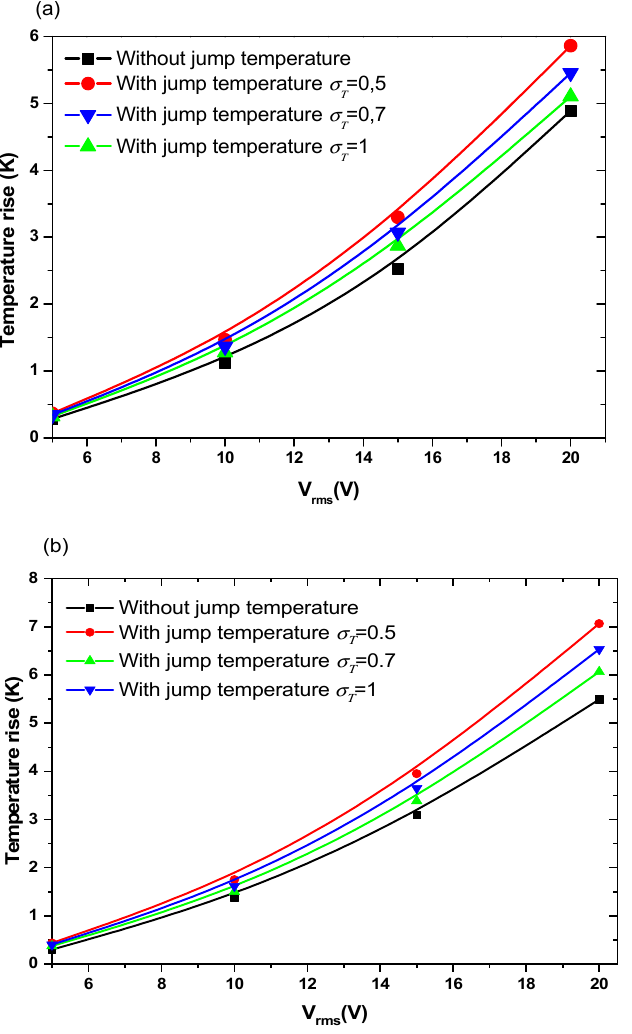
Figure 5. Temperature rise versus the applied voltage for first structure and for Knudsen number (Kn) = 0.02 and: ( a ) θ = 40°, ( b ) θ = 160°.